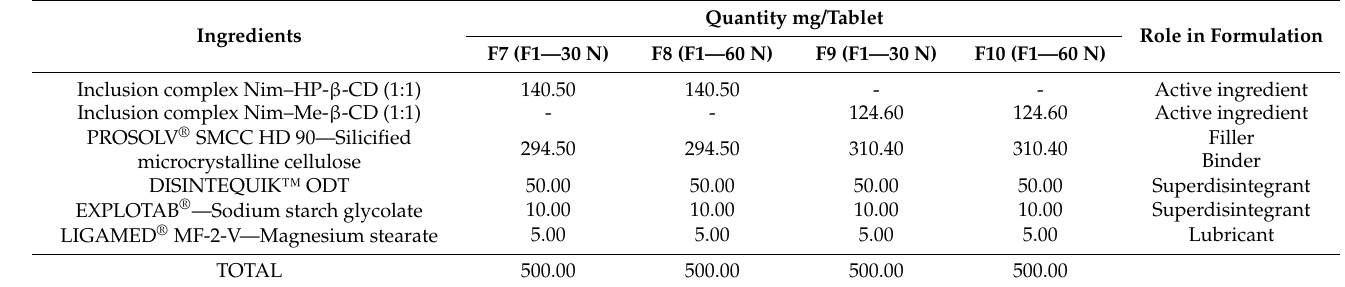
Table 2. The formulations of the tablets with Nim–HP- β -CD and Nim–Me- β -CD inclusion